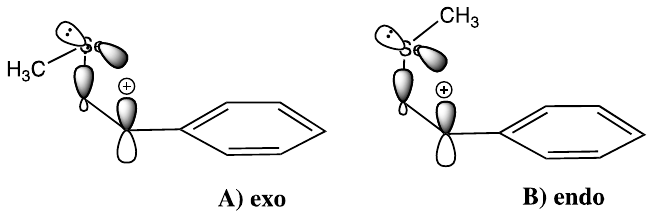
Figure 5. Low energy conformations of the seleniranium ion 12